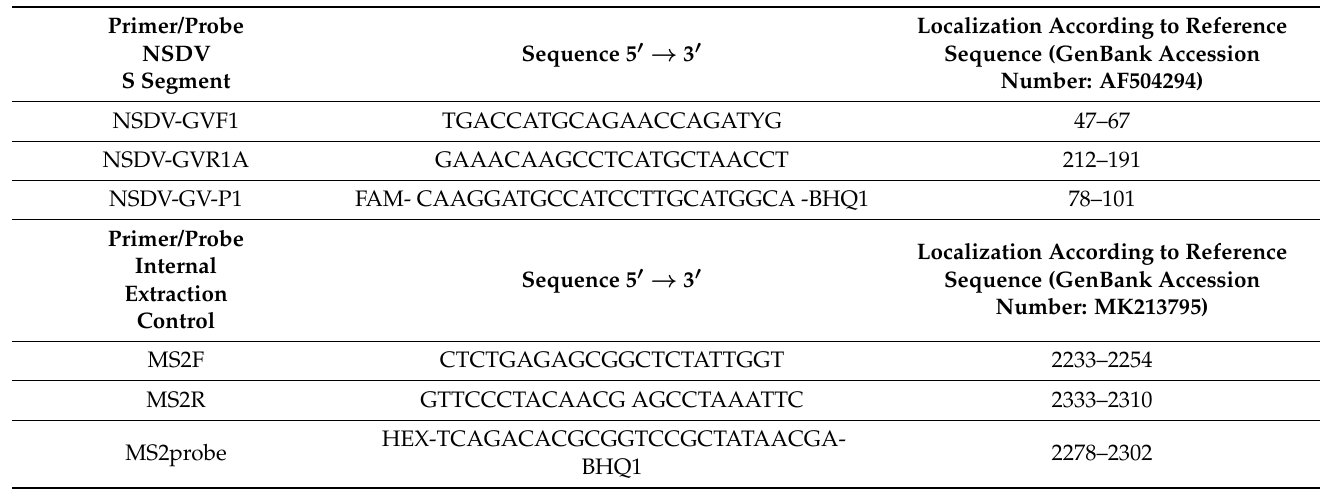
Table 1. Sequences of primers and probes used for the detection of NSDV